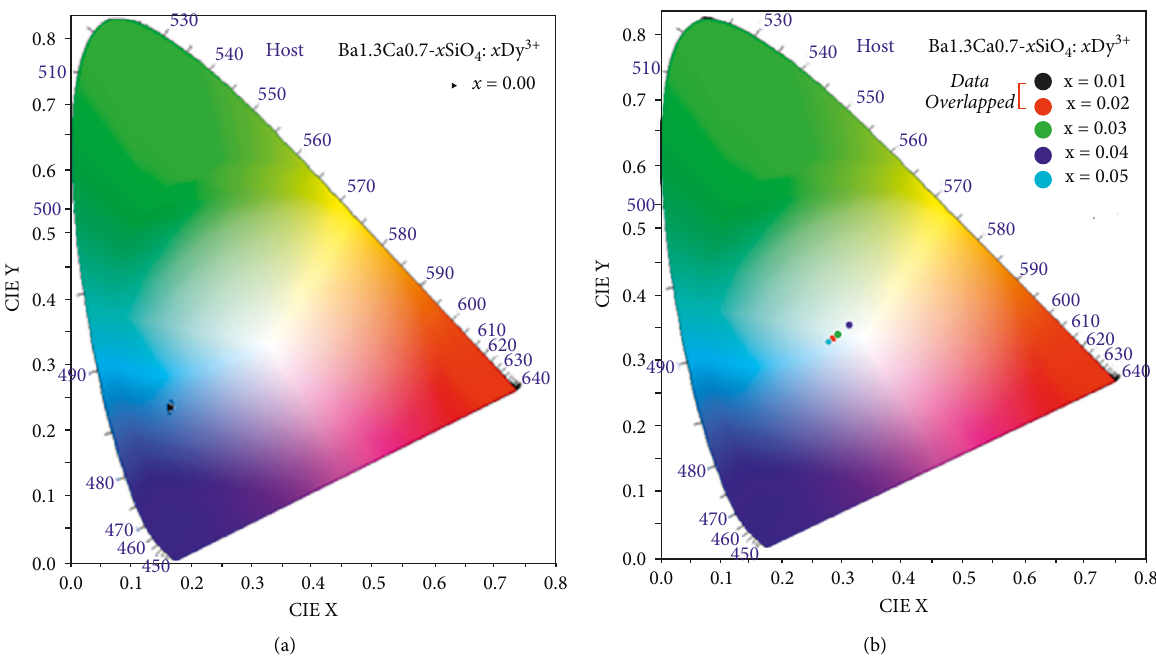
Figure 7: CIE chromaticity diagrams for (a) the host Ba Ba1.3Ca0.7 − xSiO4: x Dy 3+ ( x � 0.01, 0.02, 0.03, 0.04, and